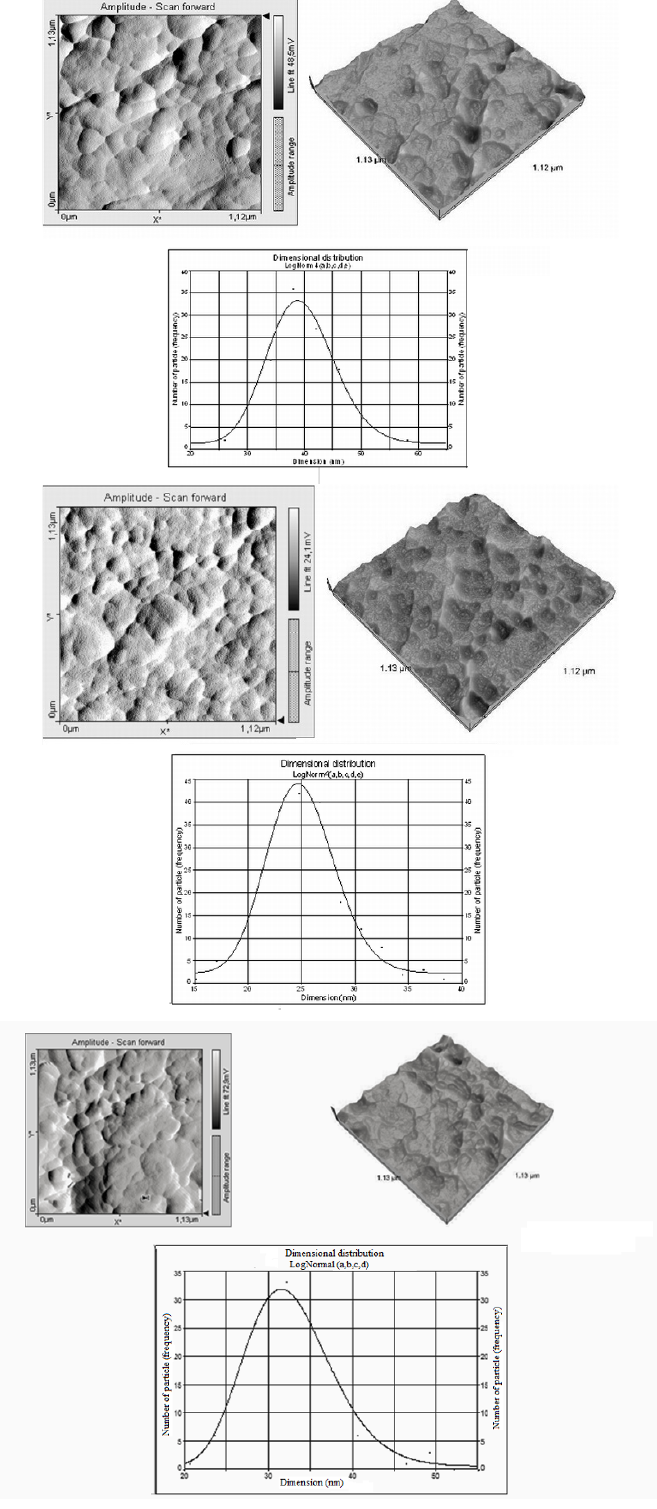
Figure 3. AFM image with scan area of 1.13×1.12 µm, dimensional distribution of particle for S1 (3a), S2 (3b), and S3 (3c) synthesized by ultrasonically assisted hydrothermal